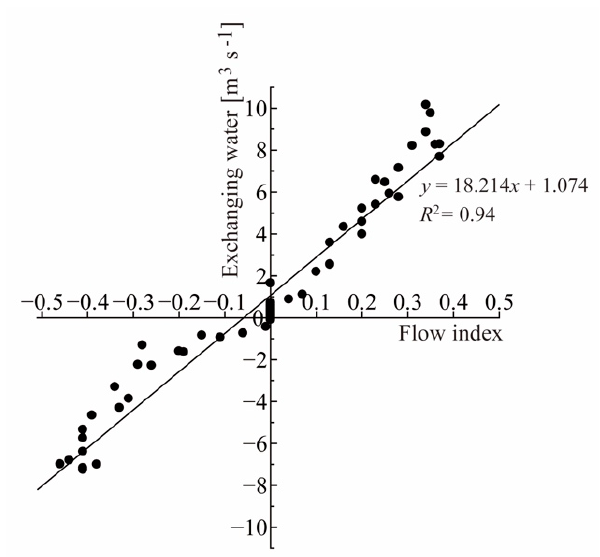
Figure 5. Relationships between the estimated index of velocity and measured discharge by ADCP at the river mouth in a small estuarine mangrove.